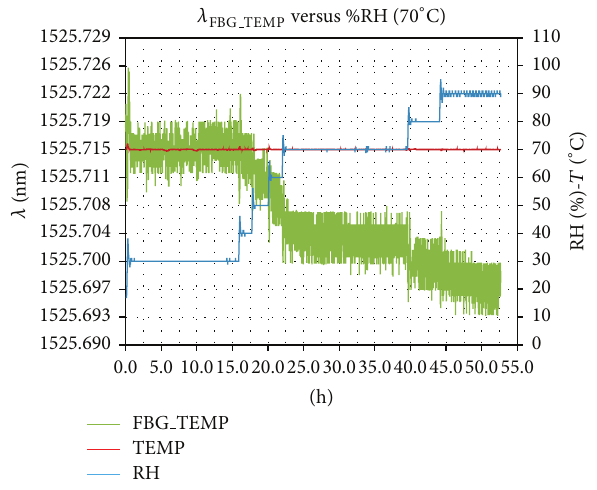
Figure 7: Bragg wavelength shift of FBG TEMP (green, left axis) as a function of %RH (blue, right axis) at a temperature of 70 ∘ C (red, right